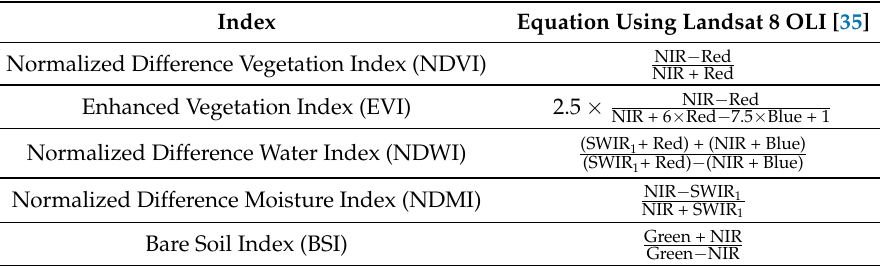
Table 2. Spectral indices